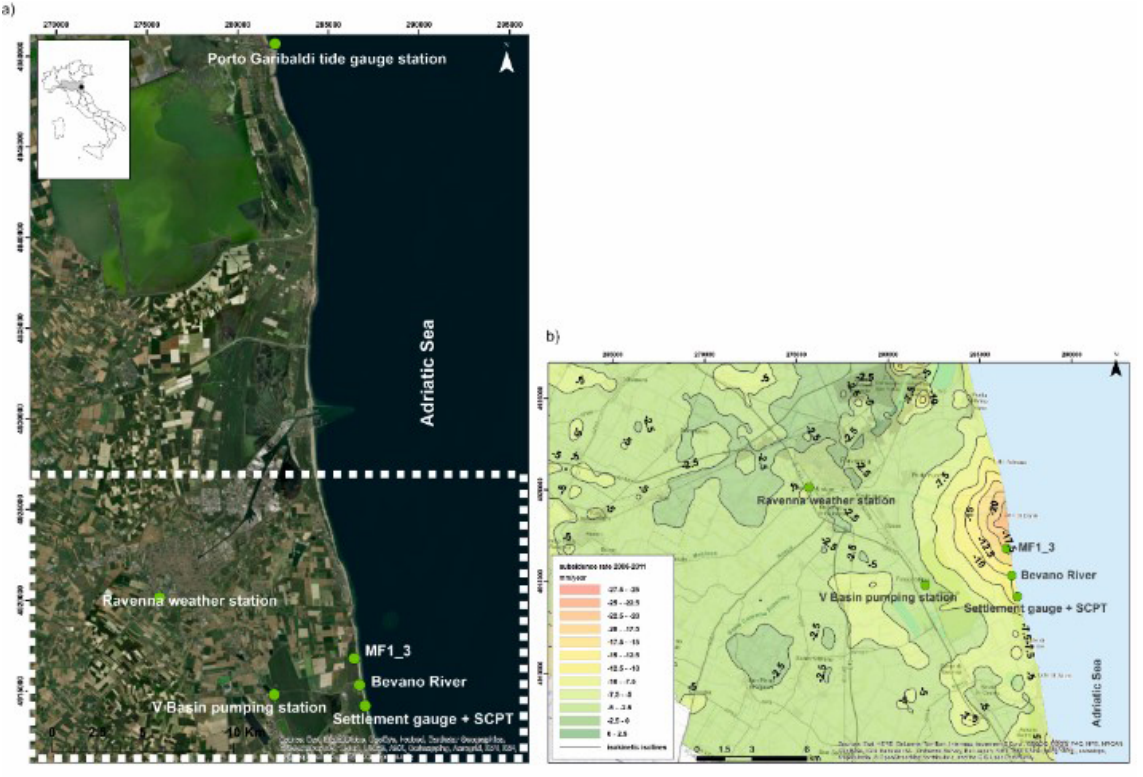
Figure 1. (a) Study area and location of the monitoring stations. The green dots represent the locations of data acquisition: MF1_3 piezome- ter, “Settlement gauge + SCPT (Standard Cone Penetration Test)” see Fig. 2; (b) Subsidence rate and isokinetic isolines (2006–2011) of the